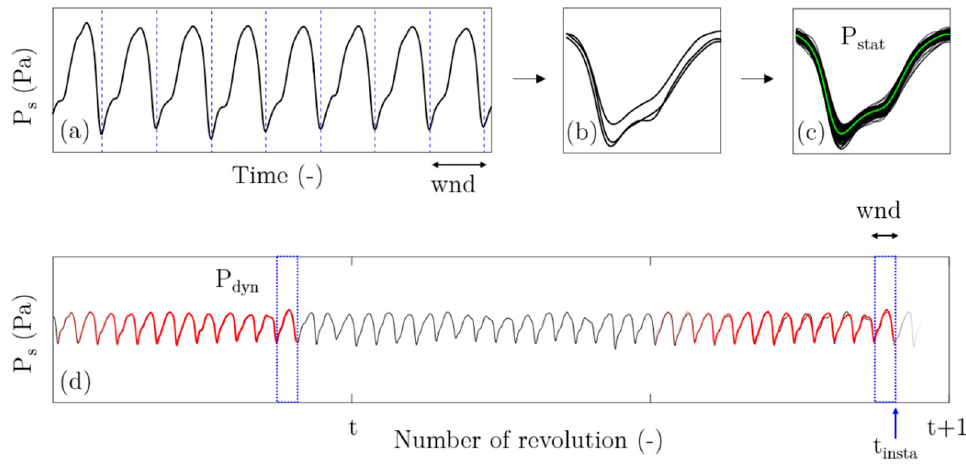
Figure 5. Construction of the reference profile. Static reference profile ( a – c ); dynamic reference profile ( d ).